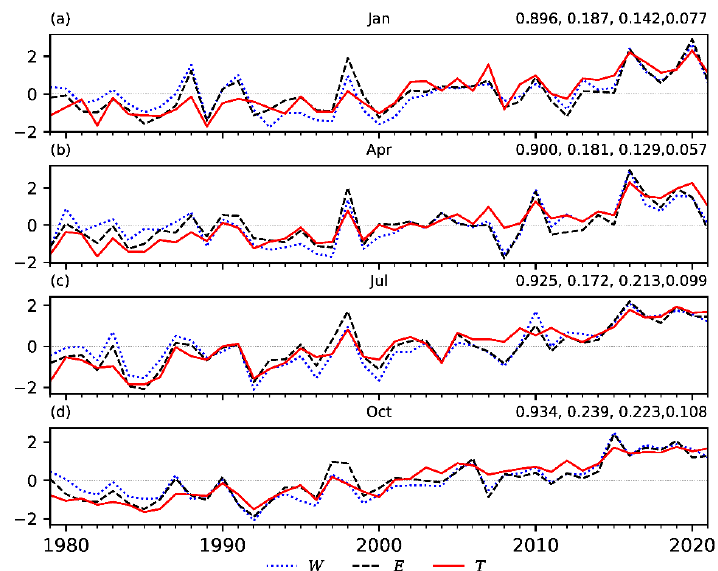
Figure 8. The time series of normalized global areal-weighted averages of 2 m temperature ( T ), PW ( W ), and SVP ( E ) in January ( a ), April ( b ), July ( c ), and October ( d ) calculated with ERA5 datasets. The four numbers at the top-right of subgraphs are the correlation coefficient between PW and SVP and Sen’s slope value of three elements ( T , W , and E in sequence; units: K/10 yr, kg ∙ m − 2 /10 yr, and hPa/10 yr), separately.